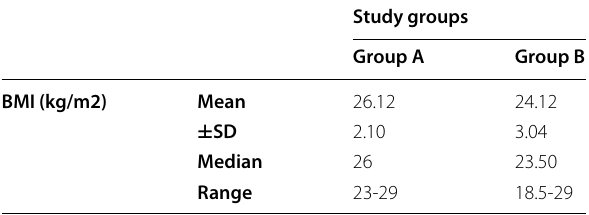
Table 2 Mean MBI in both groups